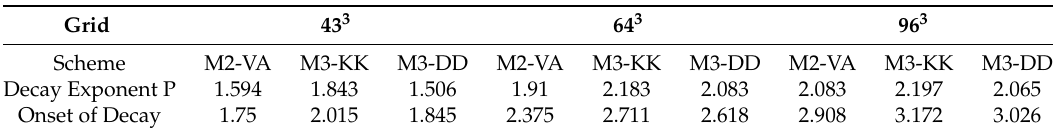
Table 1. Decay exponent and onset of kinetic energy decay obtained using high-order non-oscillatory finite volume numerical schemes.